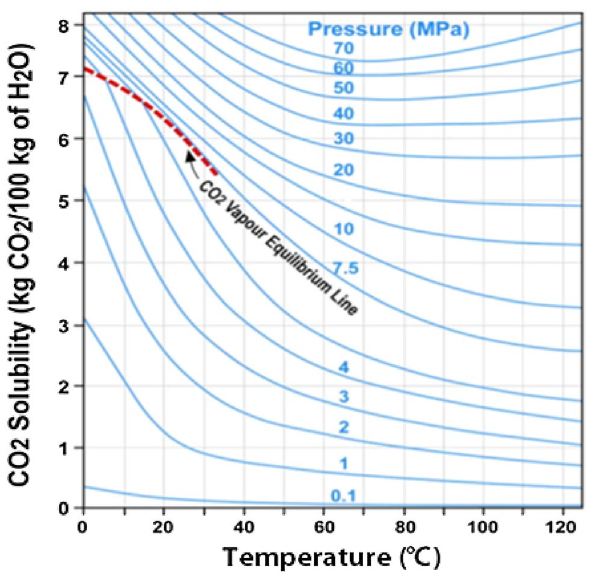
Fig. 2 CO 2 solubility in water depends on temperature and CO 2 pres- sure (Perkins